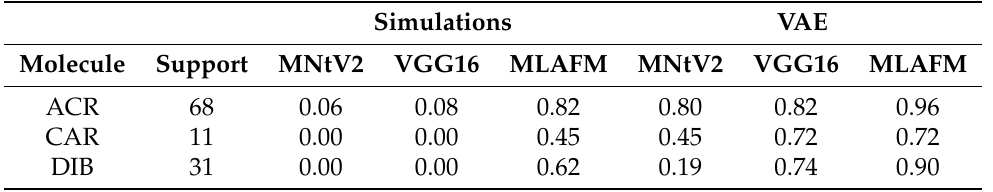
Table 1. Results achieved in the classification of 110 experimental images for acridine (ACR), car- bazole (CAR), and dibenzothiophene (DIB) by the two standard models, MobileNetV2 (MNtV2) and VGG16, and the ML-AFM model developed in this work (see Section 3.2). Support refers to the number of images of each molecule included in the testing set. The column labelled “simulations” shows the results for the corresponding model trained only with theoretical simulations, while “VAE” corresponds to the results when the training set also includes the 540 images generated from only three experimental images with the VAE described in Section 3.3. This small enlargement, just 0.17%, improves significantly the performance of the standard models and confers our ML-AFM an accuracy closer to the one achieved with theoretical